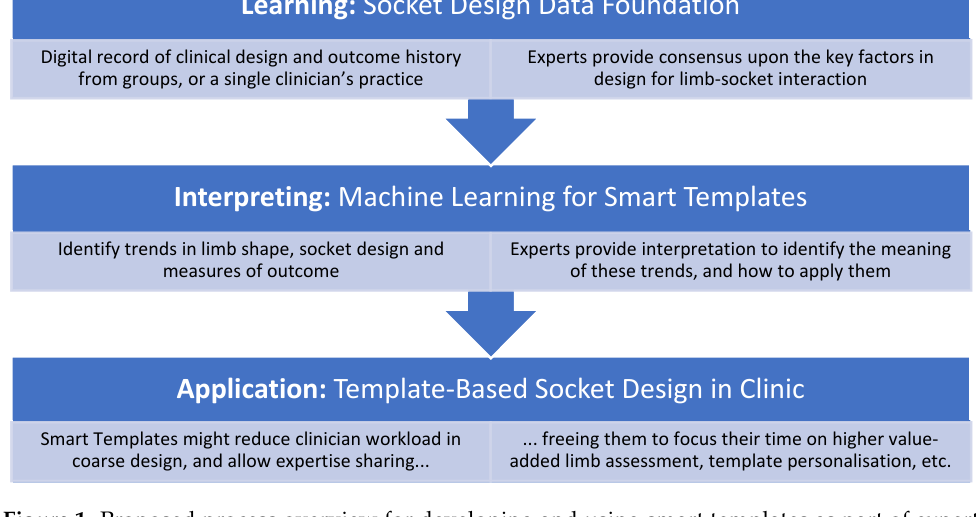
Figure 1. Proposed process overview for developing and using smart templates as part of expert- informed, evidence-based socket design. Instead of automating design at the expense of clinicians, the proposal includes the experts in each stage of development and clinical use.